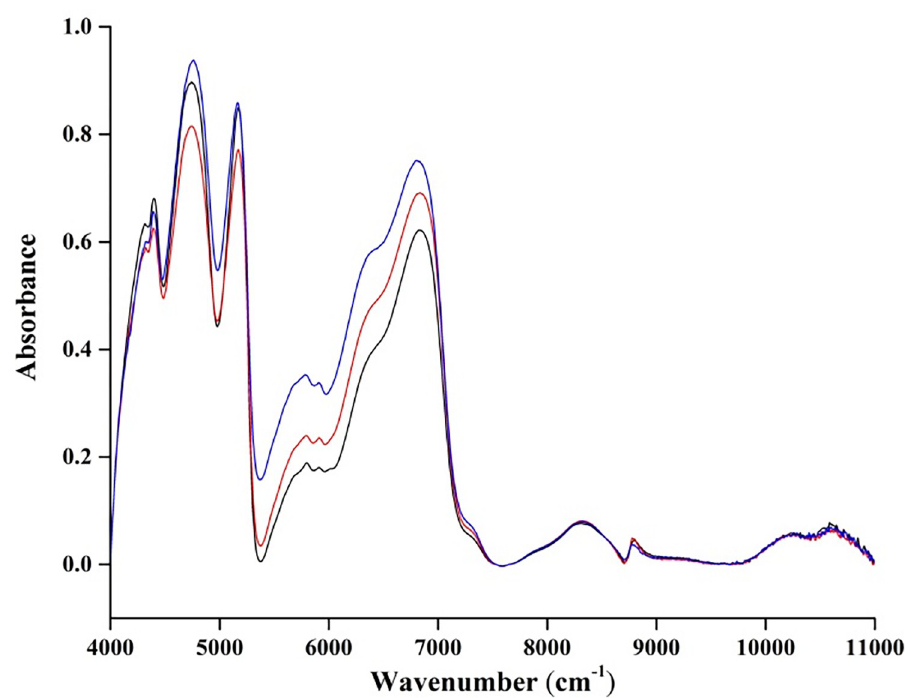
Fig 1. Arbitrary three baseline-corrected skin